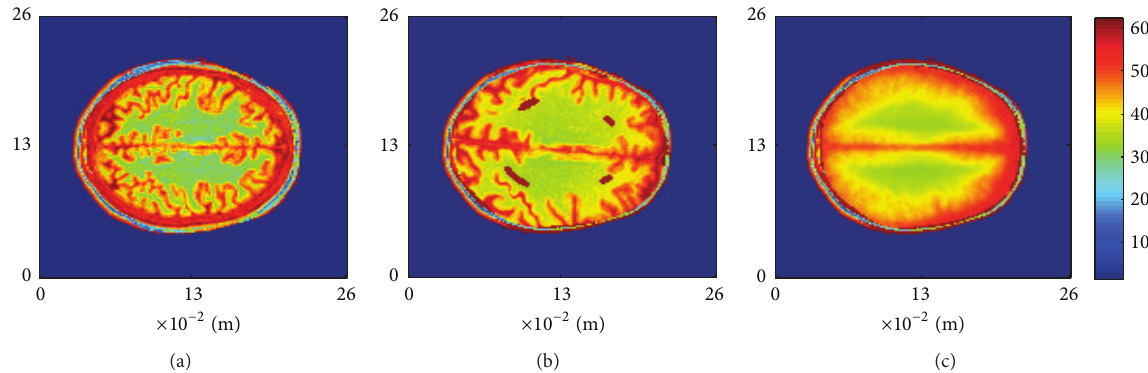
Figure 5: Reconstruction in the absence of stroke. The left panel is the patient’s brain map; the middle panel is the result of the reconstruction using the RM initial guess; the right panel shows the reconstruction using the AMM initial guess.